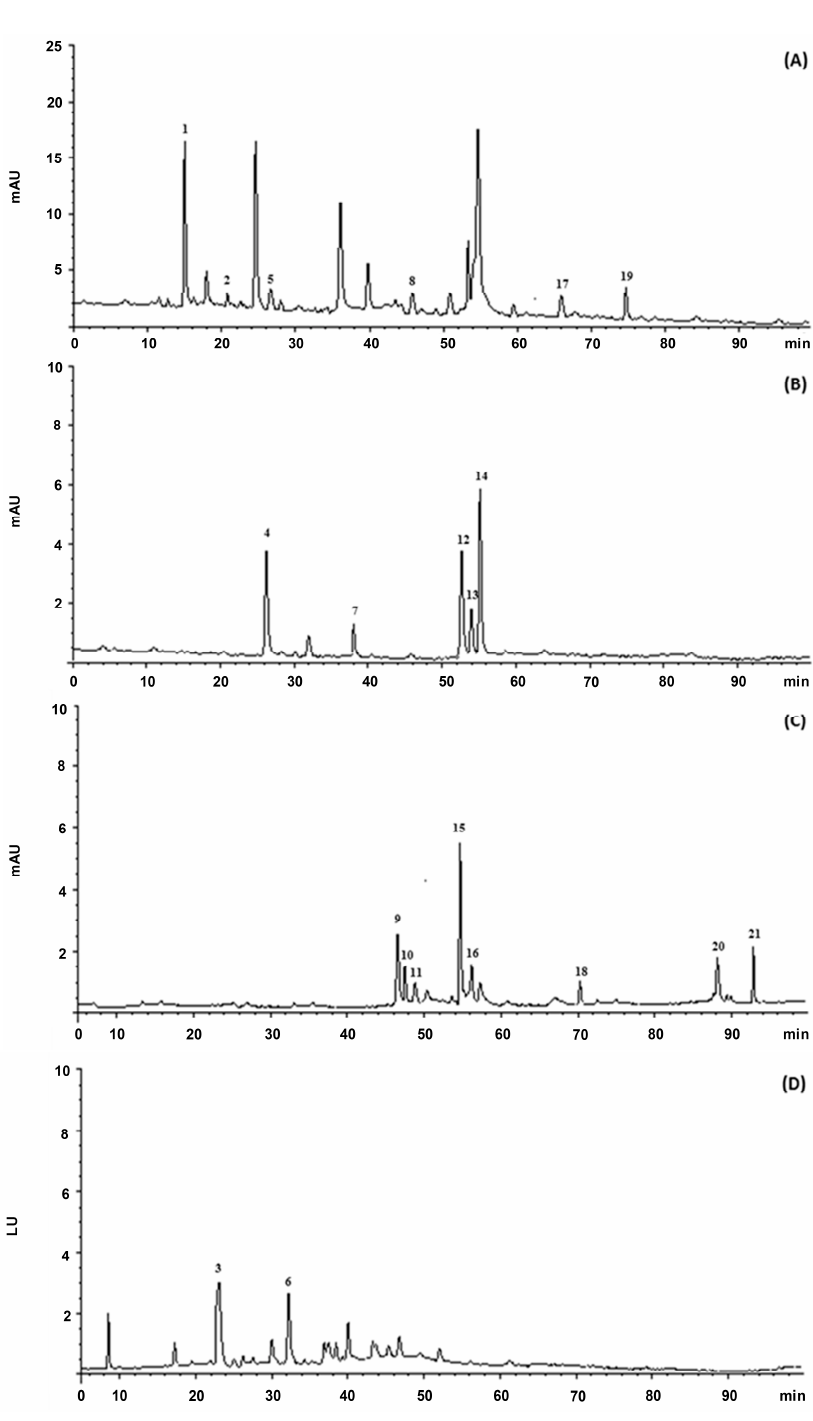
Figure 1. Representative HPLC chromatogram of phenolic compounds present in the methanol extract of NS: ( A ) 280 nm, ( B ) 330 nm, ( C ) 370 nm and ( D ) λ ex 276 nm, λ em 316 nm. The numbering of the peaks refers to Table 2.